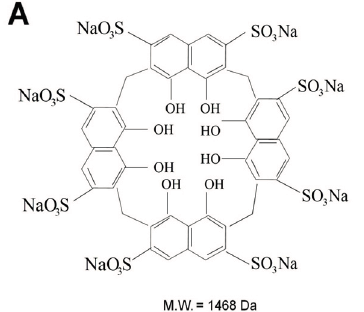
Figure 1. Effect of ST104P on angiogenesis ex vivo. ( A ) The chemical structure of ST104P; and ( B ) Rat aortic segments were placed into the Matrigel-covered wells and treated with phosphate-buffered saline (PBS) or ST104P of the indicated dose for six days. Representative photographs of vessel sprouting were recorded and analyzed statistically (20× magnification. Scale bars = 1 mm). Data were mean ± standard error of the mean (SEM) of triplicate experiments. Asterisks indicate statistical significance versus control. * p ˂ 0.05 and ** p ˂